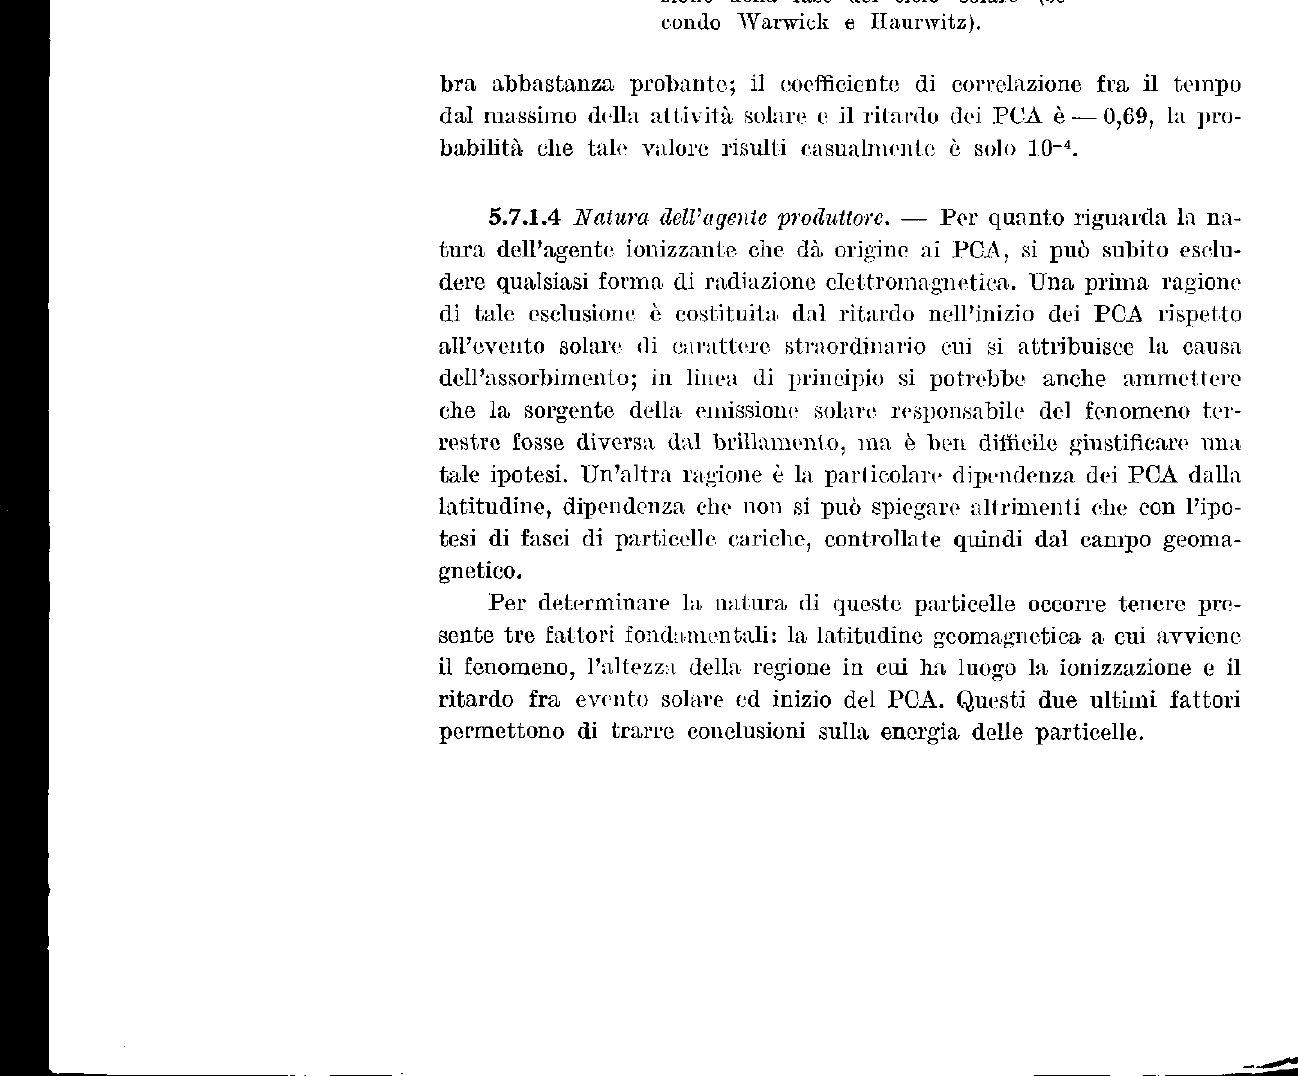
Fig. 5.46 - Andamento del ritardo At tra brillamento e inizio del PCA, in fun- zione della fase del cielo solare (se- condo Warwick e